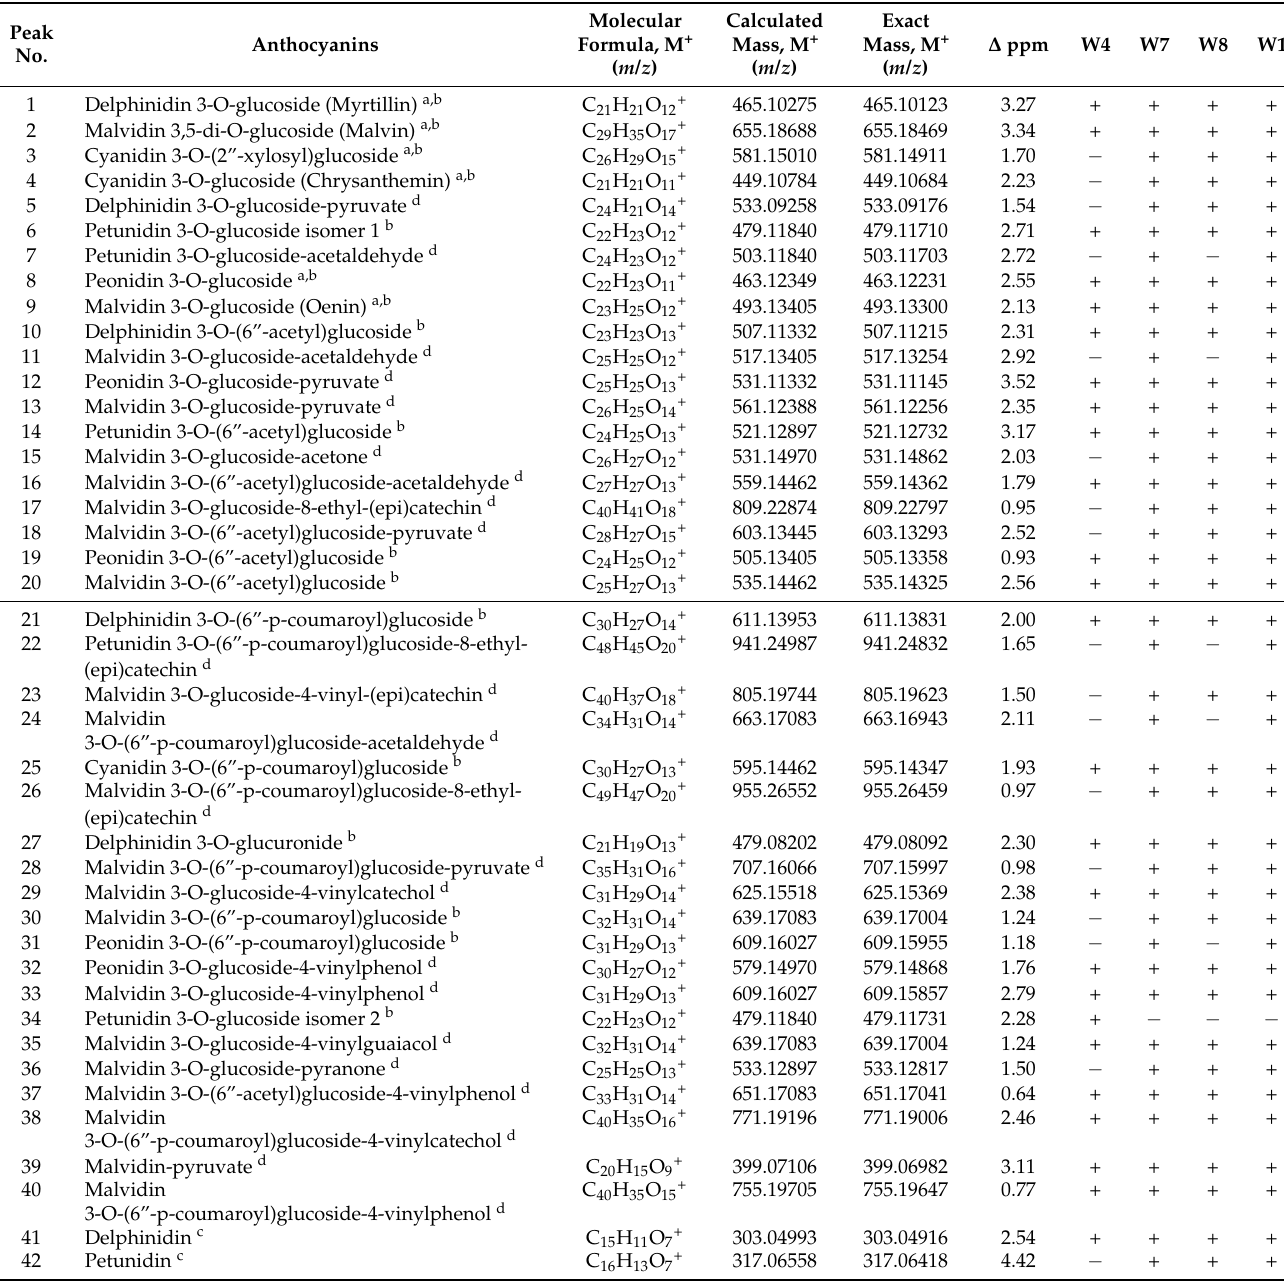
of pyranoanthocyanins, which are formed by the aging of wine. During the aging, the concentration of anthocyanins in wine decreases dramatically due to decomposition, poly- merization and reaction with other components of wine, which leads to the formation of compounds derived from anthocyanins (pyranoanthocyanins) [48]. Some of the substances reported, for instance peak 13 have been previously identified [49]. All of these derivatives were previously identified in the wine of grapevine variety Vranac ( Vitis vinifera L.) from Montenegro [9]. Table 4. High resolution MS data of anthocyanins and related compounds identified in three Italian red and one rose wine samples. Peak No.—peak numbers; ∆ ppm—mean mass accuracy; + stands for detected and − stands for not detected